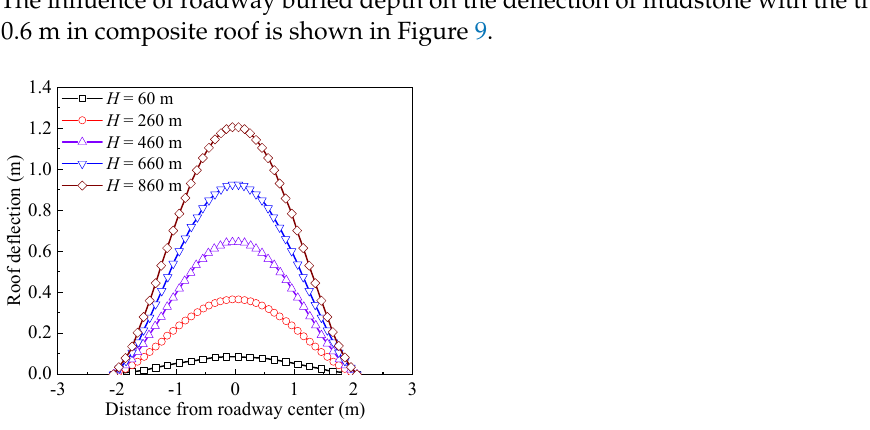
Figure 8. Relationship between composite roof deflection and roadway width.